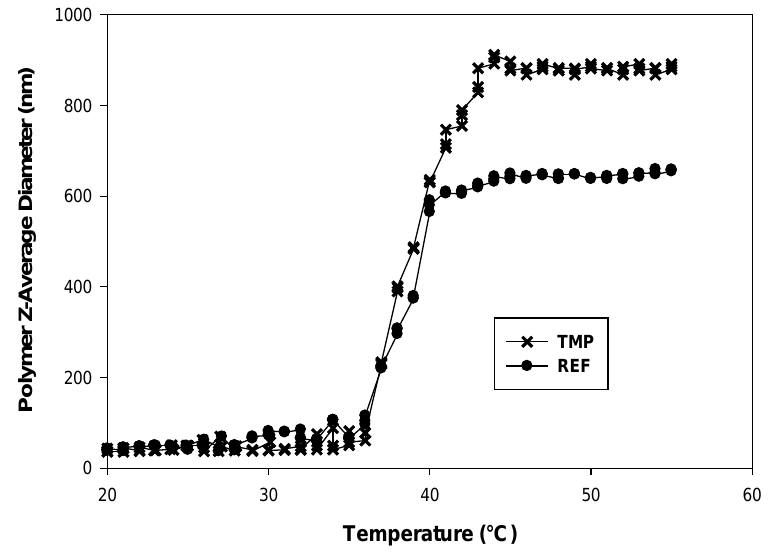
Figure 1. DLS of the TMP and REF at 1 g/L in DI Water (filtered twice with a 0.45 PET syringe